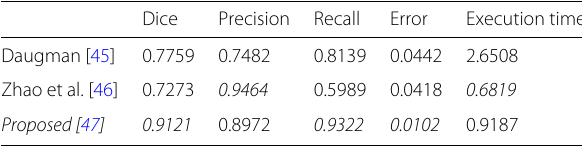
Table 4 Performance comparison for each